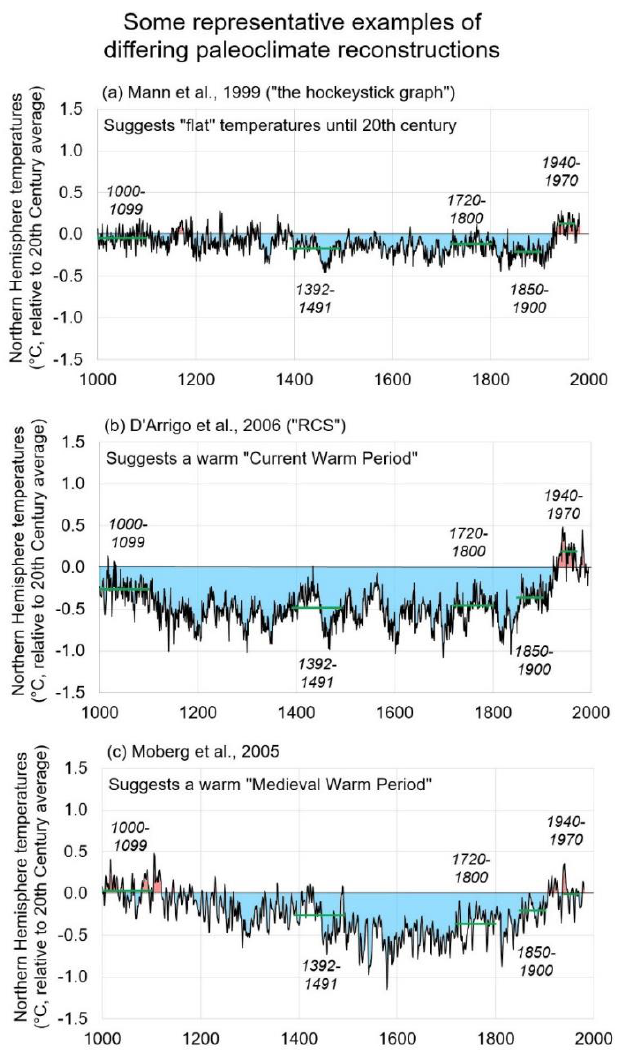
Figure 12. Examples of some of the different paleoclimate reconstructions for Northern Hemisphere temperature trends since 1000. ( a ) Mann et al. (1999) [164]; ( b ) D’Arrigo et al. (2006) [166]; ( c ) Moberg et al. (2005) [165]. The time series were downloaded from NOAA NCEI’s Paleoclimatology public data repository, https://www.ncdc.noaa.gov/data-access/paleoclimatology-data (Accessed: January 2020). Highlighted dates correspond to different proposed baseline periods for the “pre-industrial” era, as discussed in the text. The horizontal axes correspond to years.